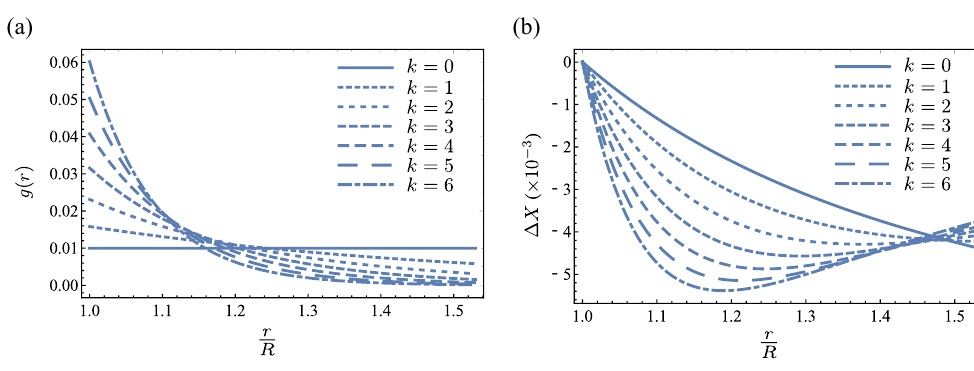
Figure 5. (a) Stress-free strain and (b) crack closure for problem (ii) for different values of k .